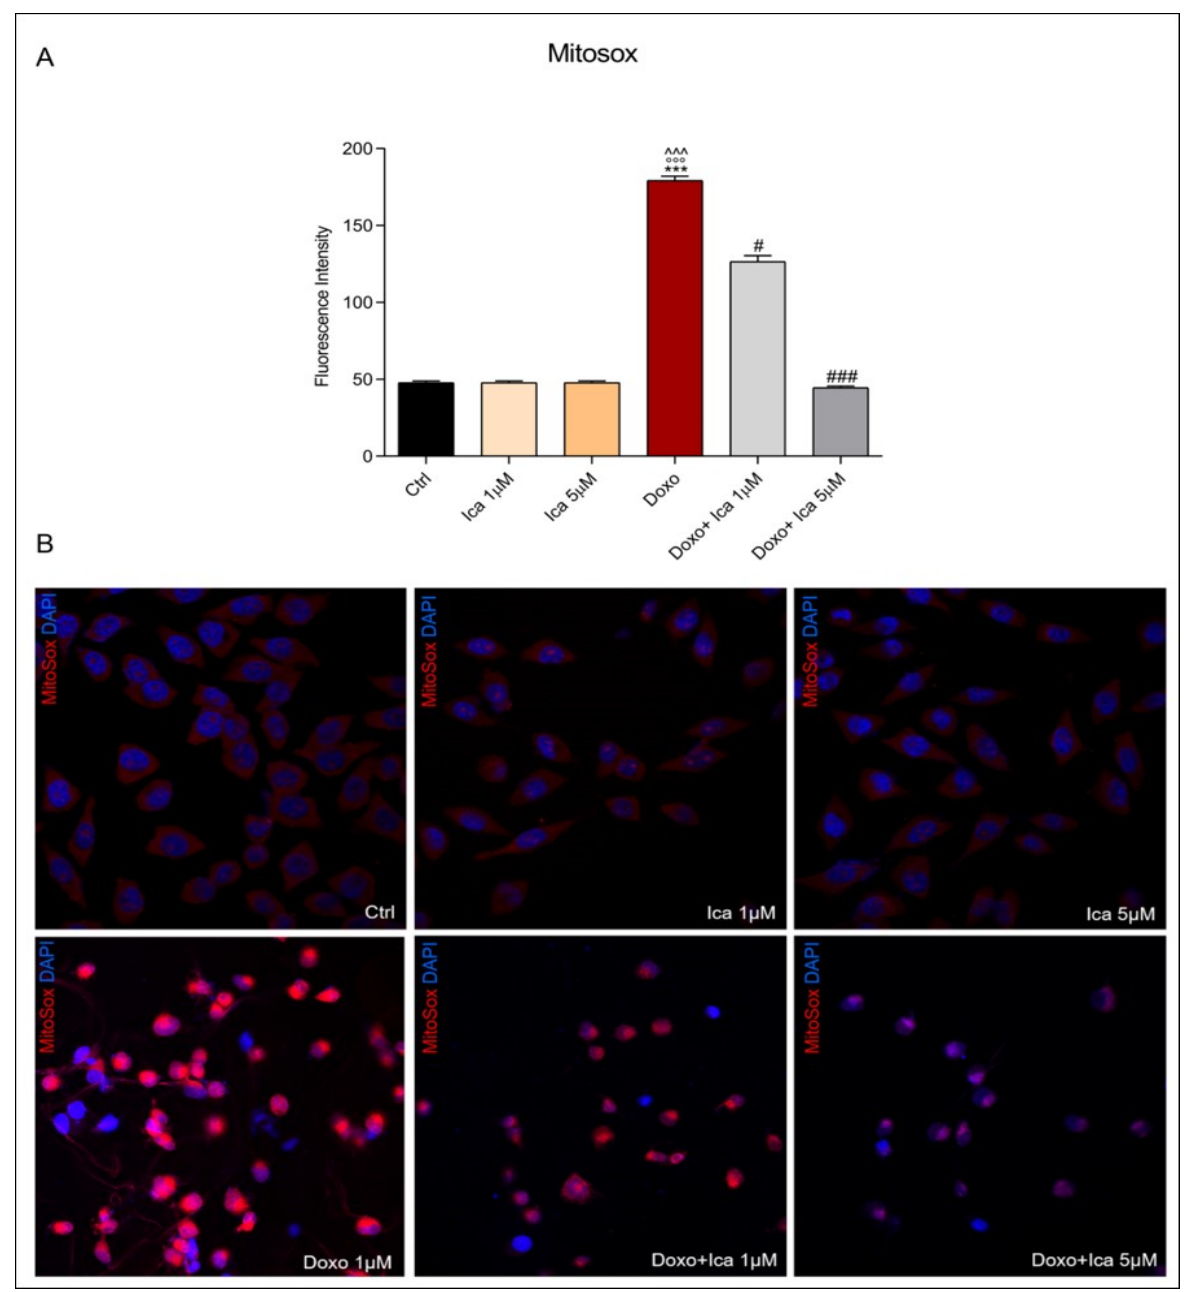
Figure 4. The effect of Ica on mitochondrial superoxide overproduction. ( A ). Superoxide (O 2 − ) levels were determined by immunofluorescence assay. Fluorescence was quantified using ImageJ ® software by converting the intensity to a greyscale value based on the RGB colour model. For each treatment, 30–40 cells were processed. Significant differences in mean fluorescence were found between all treated cells. ( B ). Representative confocal images of H9c2 cells treated as described above. Red staining showed the MitoSOX fluorescent probe used to identify mitochondrial O 2 − overproduction, blue staining showed DAPI (4’,6-diamidino-2-phenylindole), used for nucleic acid staining. Cell images were collected using a 40× confocal microscope objective. Data are expressed as mean ± SEM., *** p < 0.001 vs. Ctrl; °°° p < 0.001 vs. Ica 1 μ M; ^^^ p < 0.001 vs. Ica 5 μ M; # p < 0.05 vs. Doxo; ### p < 0.001 vs. Doxo; Kruskal-Wallis test and Dunn’s multiple comparisons test ( n = 3). Data is for three independent experiments.